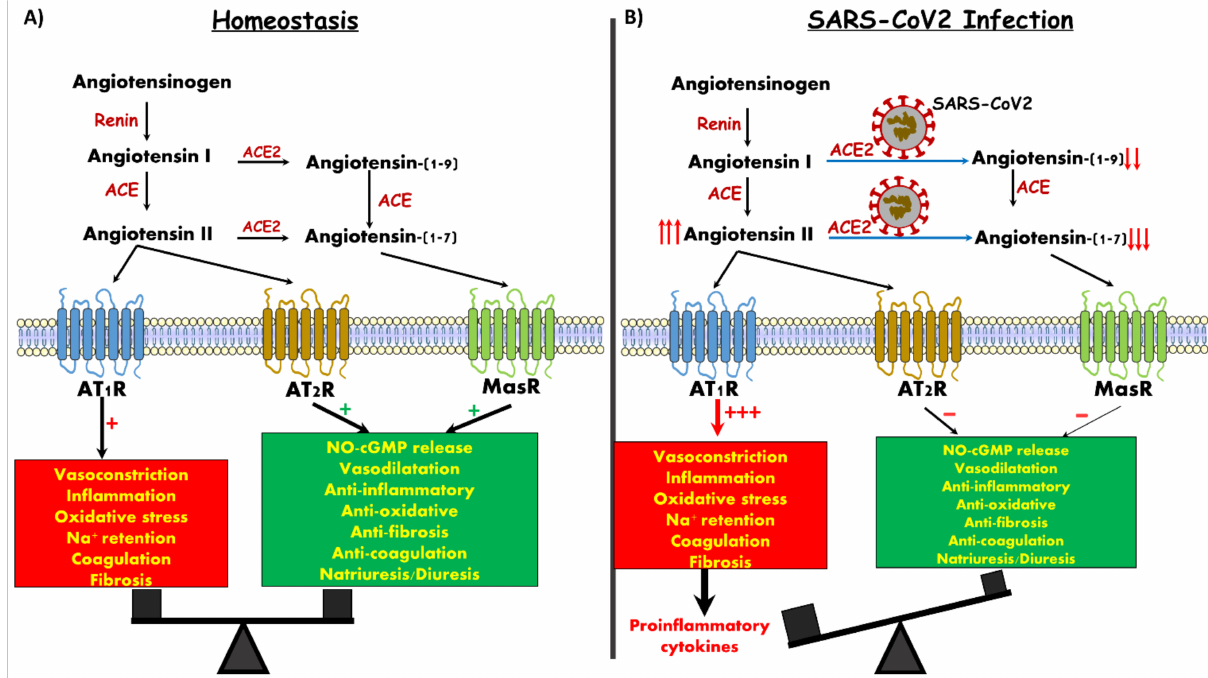
Figure 1. Angiotensin derivatives, their targets and downstream action. ( A ) Balanced impact of Ang II and Ang 1-7 on vascular tone and control of inflammation. ( B ) SARS-CoV-2 infection generates Ang 1-7 depletion, likely leading to unopposed vasoconstriction and